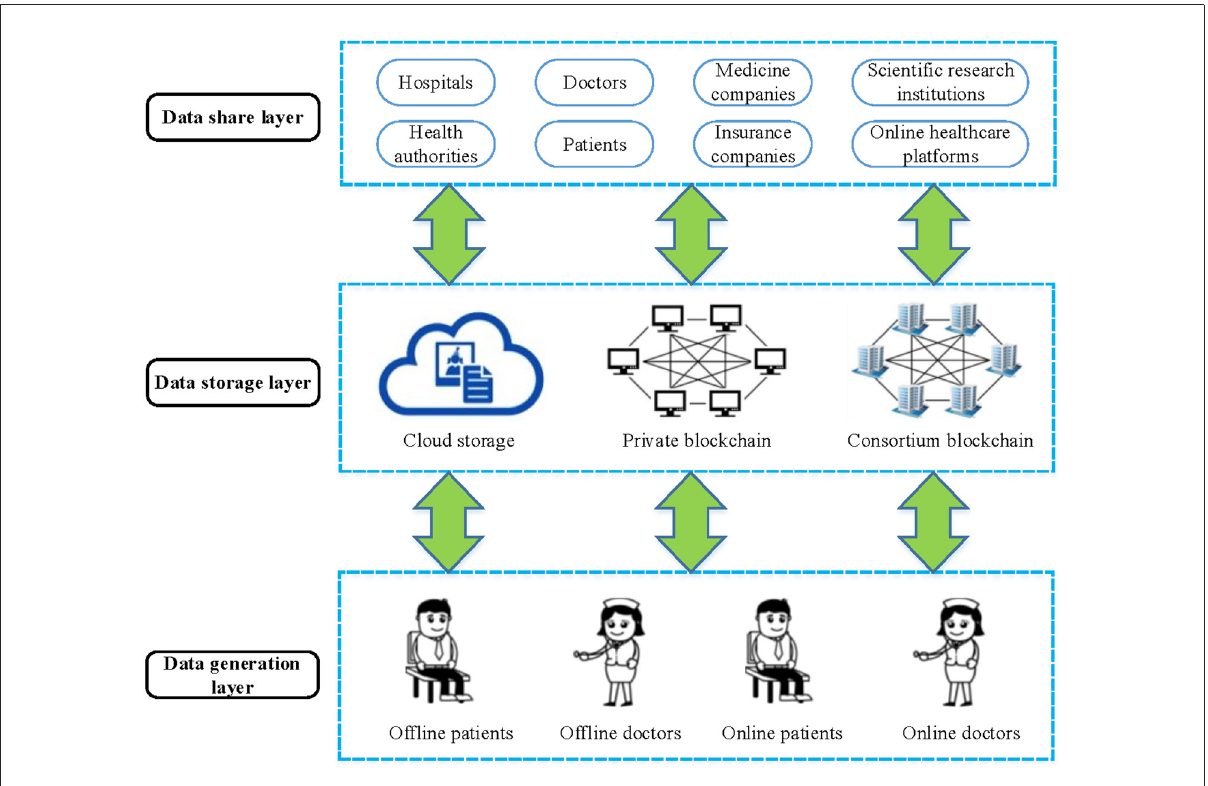
FIGURE1 The architecture of the MBDS